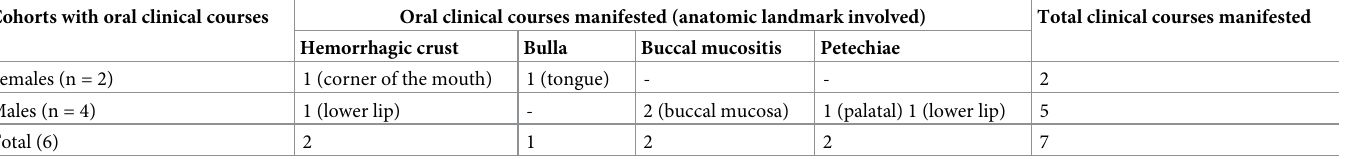
Table 2. Oral clinical courses manifested among patients with SARS-CoV-2 infection during the home-based follow-up. Cohorts with oral clinical